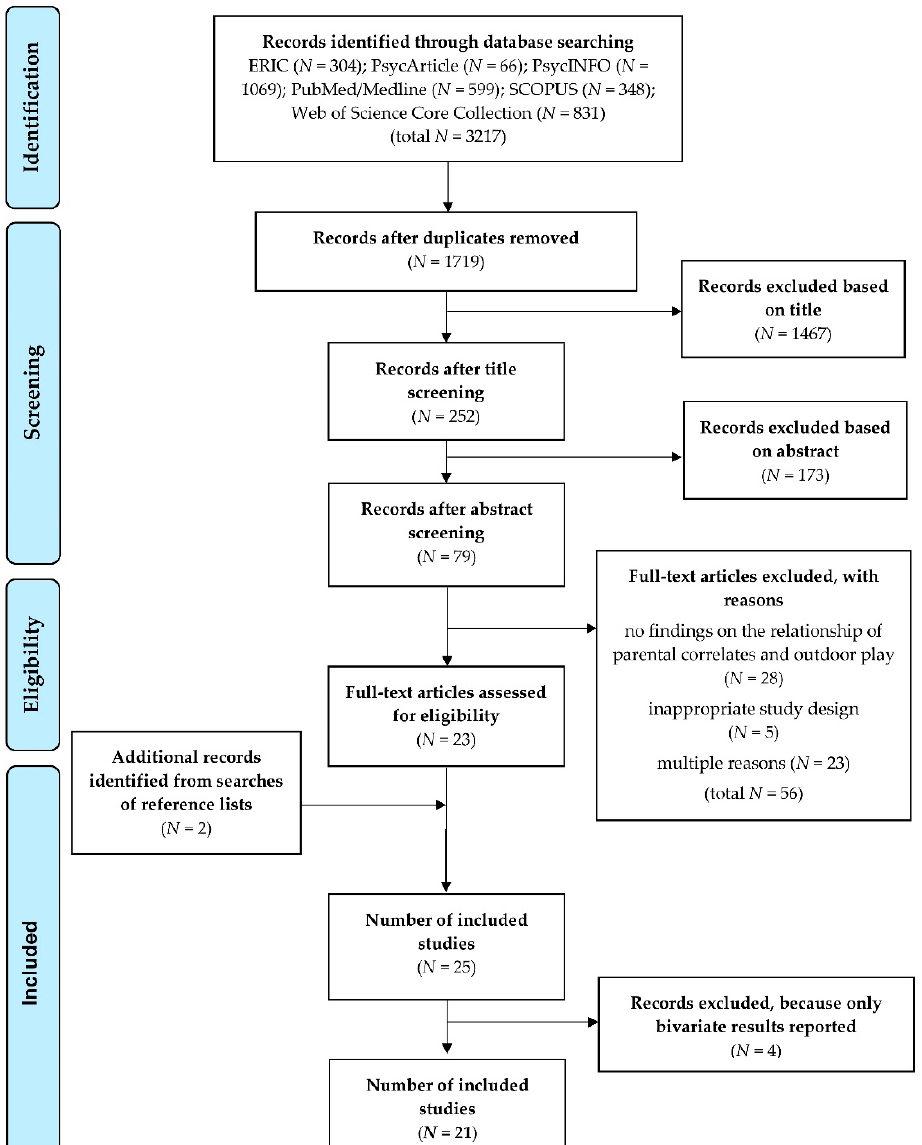
Figure 2. Preferred reporting items for systematic reviews and meta-analyses (PRISMA) flow diagram [37] presenting the results of the research, screening and selection processes of the present review.